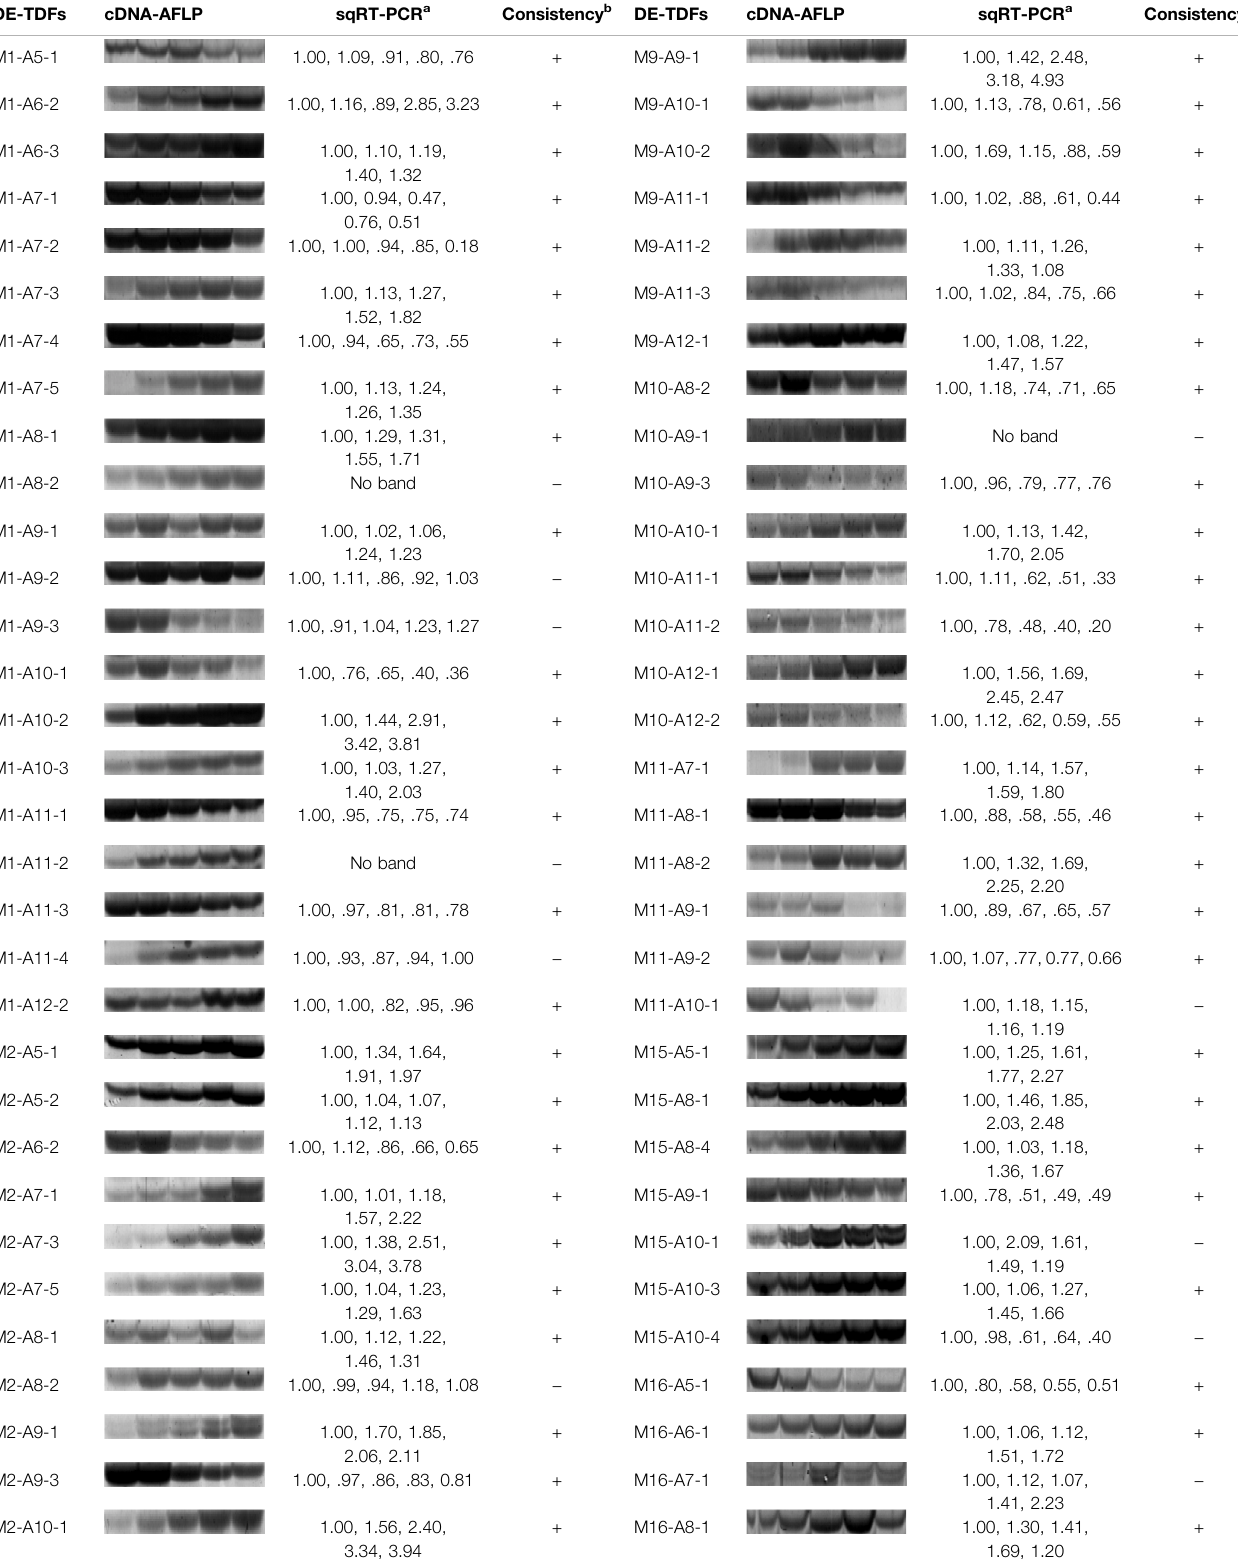
TABLE 2 | Semi-quantitative RT-PCR validation of DE-TDFs for the pro fi les in virgin Hevea trees.